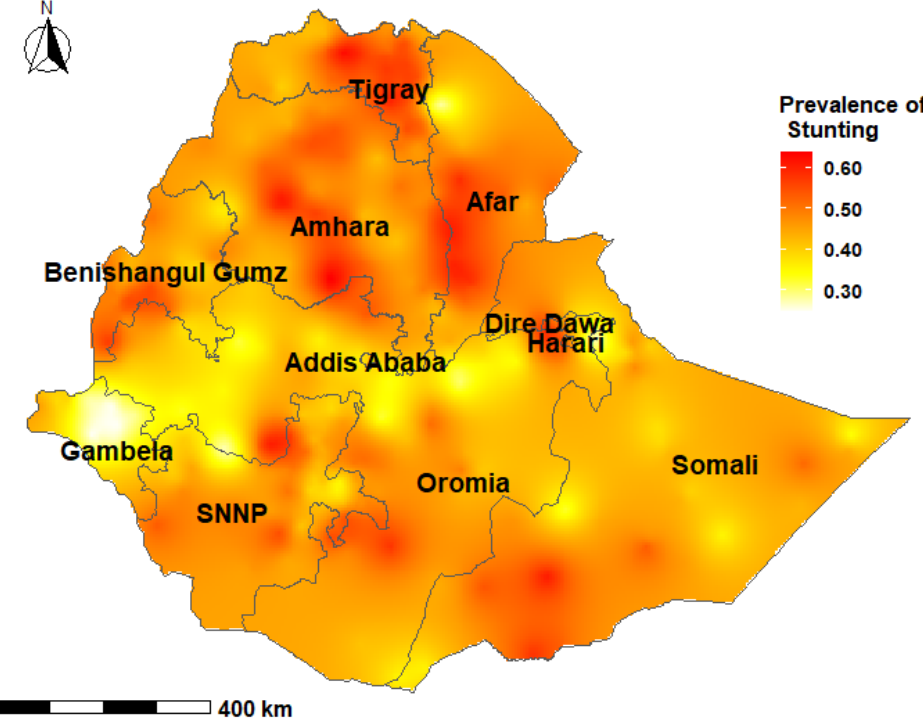
Figure 4. Predicted prevalence of stunting among children 24–59 months of age in Ethiopia, 2016 EDHS.